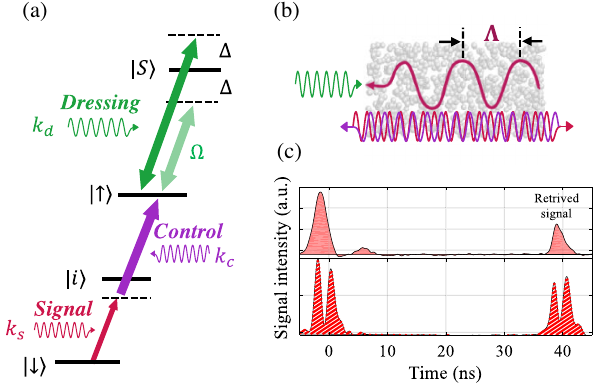
FIG. 3. Experimental realization of continuous protection from motional dephasing. (a) Light storage scheme: Counterpropagat- ing pulses of a strong control field and a weak signal field with wave vectors k and k coupling the ground state j ↓ i to the c s excited state j ↑ i through an intermediate state j i i . A dressing beam with wave vector k couples j ↑ i to the sensor state j S i with d Rabi frequency Ω and detuning Δ . (b) The signal and control pulses generate a collective excitation with wave vector 2 π = Λ ¼ k − k . The dressing-field wave vector k has an s c d opposite direction and a larger magnitude. (c) Typical data traces when the incoming and retrieved signals are either directly measured (top) or interfered with reference pulses to measure the phase of the signal (bottom).